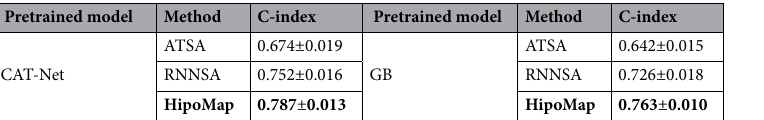
Table 5. Comparison of c-index between the benchmark methods and our proposed HipoMap. The best performance is highlighted in bold.